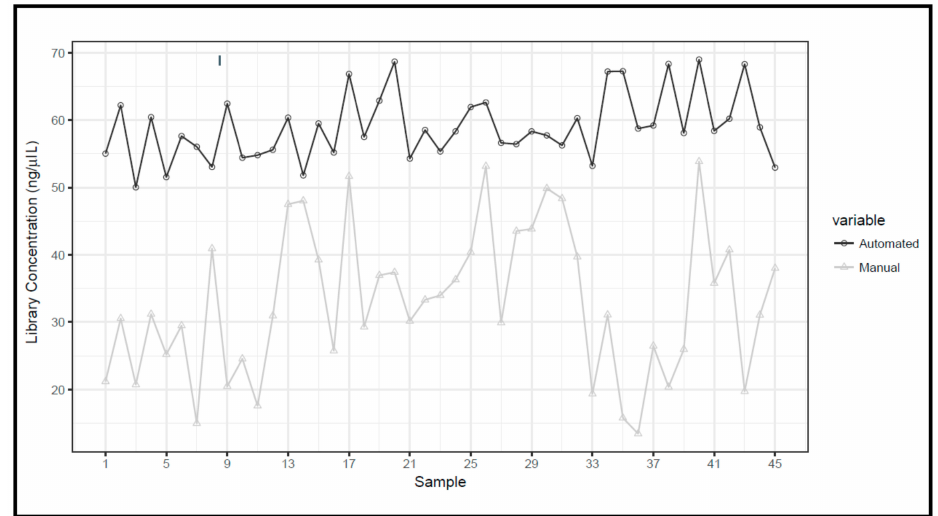
Figure 8. Evaluation of the uniformity of BRCA1 / 2 library concentration by PicoGreen ® dsDNA quantitation assay.